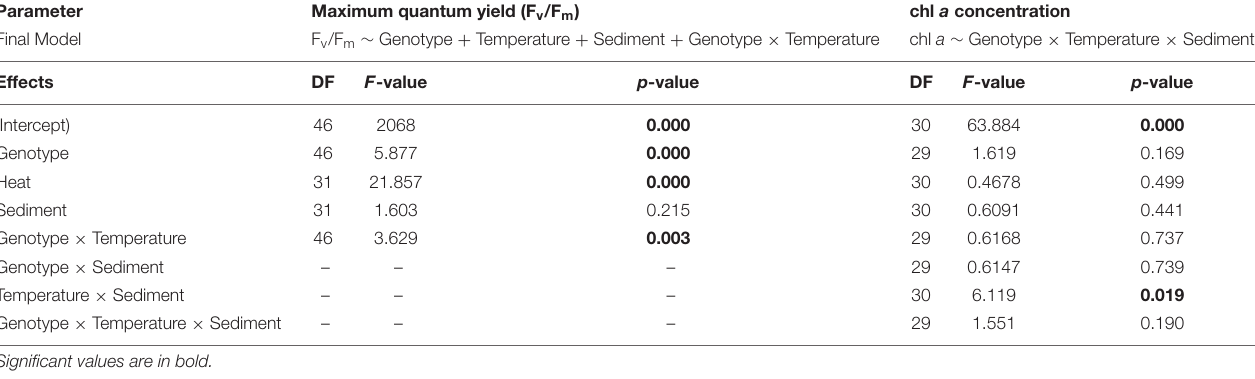
TABLE 2 | Results from linear mixed-effects model on the effects of different treatments on F v /F m and chl a concentration, using control as the reference category (intercept).